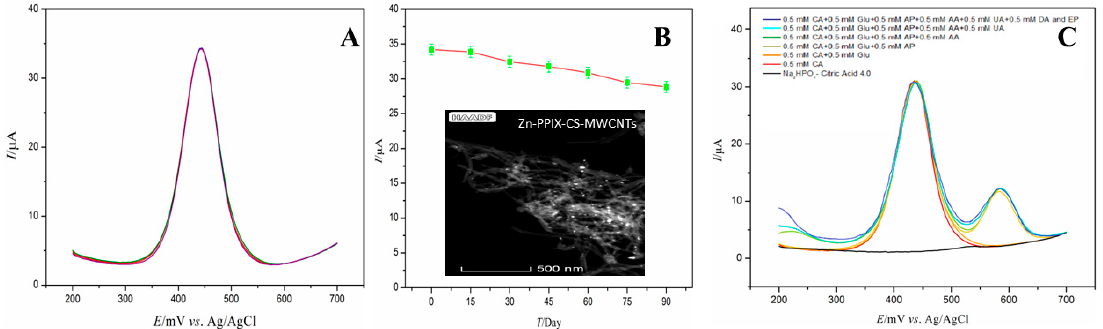
Figure 7. ( A ) Five GC electrodes modified with Zn–PPIX–CS–MWCNTs were prepared by the same procedure and determined in 0.05 M Na 2 HPO 4 –citric-acid solution (pH 4.0) containing 0.5 mM caffeic acid. ( B ) The response of oxidation-peak current of the same GC electrode modified with Zn–PPIX–CS–MWCNTs was determined to be 0.5 mM caffeic acid at an interval of 15 days. Error bars = ± standard deviation, n = 5. ( C ) Interference test of the fabricated biosensor in Na 2 HPO 4 –citric-acid solution (pH 4.0) containing 0.5 mM caffeic acid and the same concentration of interfering sub-